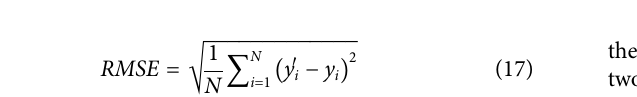
Frontiers in Energy Research |